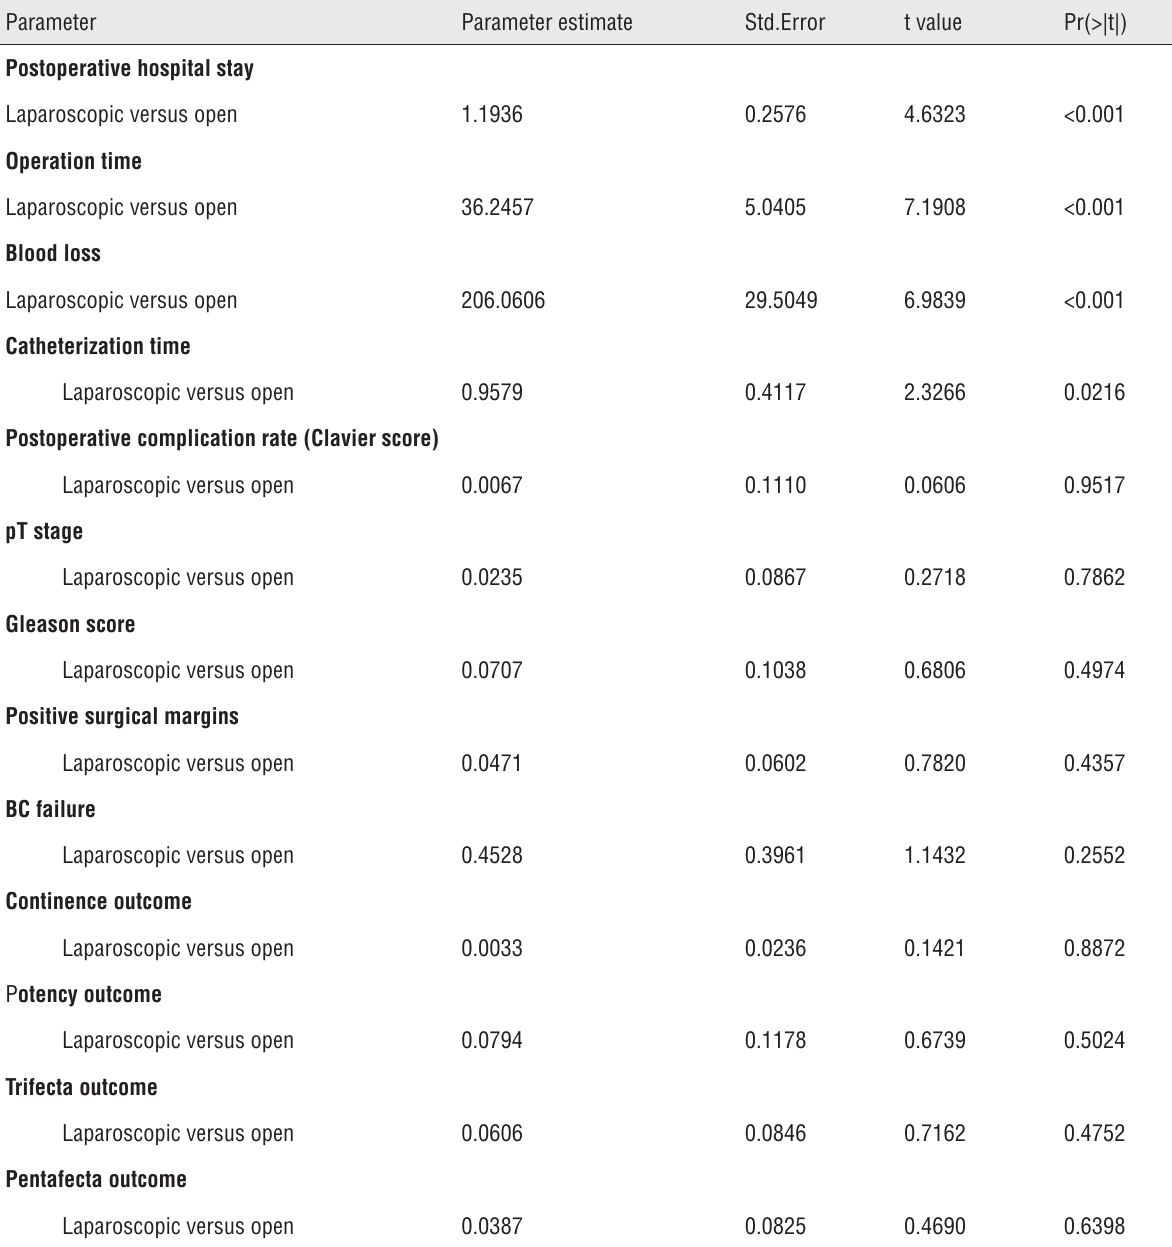
Table 8 - Linear regression model analysis: estimation of surgical approach (laparoscopic versus open) influence on perioperative, pathological and postoperative outcomes. Parameter Parameter estimate Std.Error